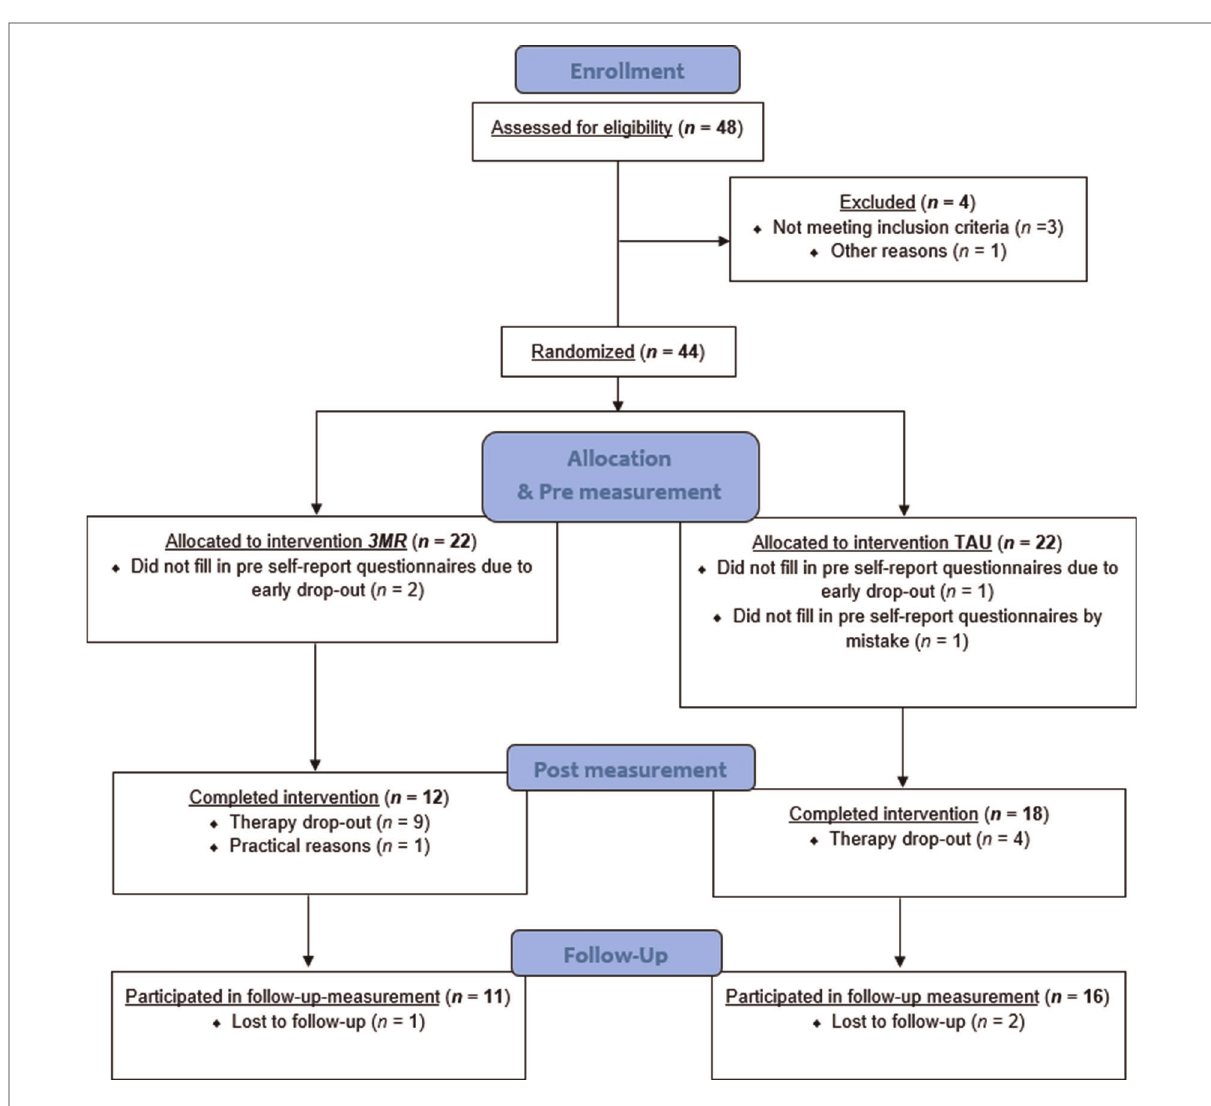
FIGURE 1 Flow diagram of the study.